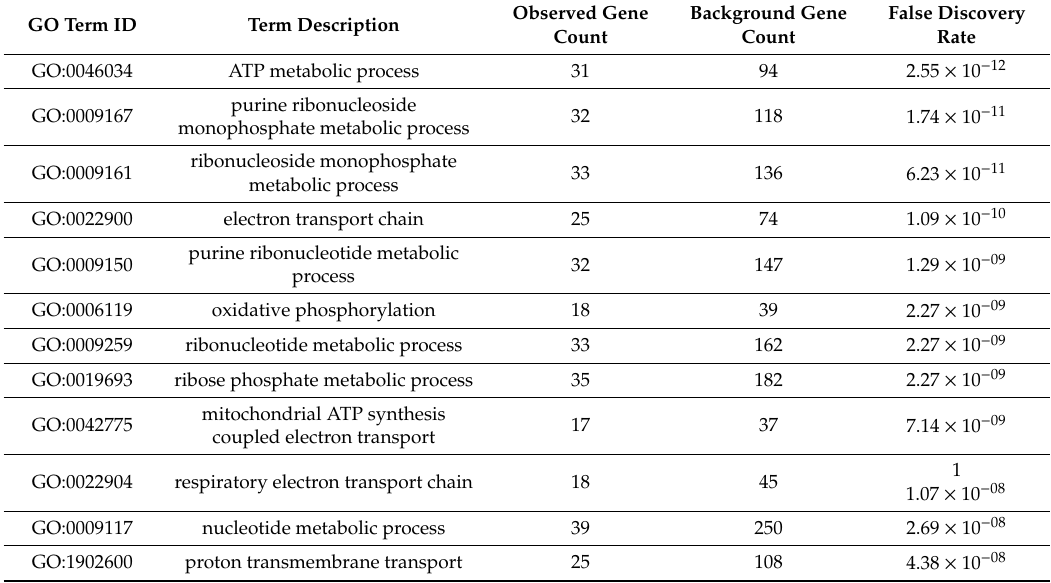
Figure 6. Codon usage trends in groups of transcripts corresponding to proteins regulated in sua5 cells. ( A ) Insoluble proteins up-regulated (fold change > 1.2, p < 0.05) in sua5 cells have corresponding transcripts that over-use AUU, ACG, AAC and AGA codons. ( B ) Soluble proteins down-regulated (fold change < 0.7, p < 0.05) in sua5 cells have corresponding transcripts that over-use AAC and AAG codons. The color-coded table describes the increased (yellow) or decreased (purple) codon frequency changes in a group of regulated proteins relative to genome averages (Codon -Group - Codon -Genome ) for each of 64 codons, with white boxes describing changes less than 0.05. The t 6 A dependent codons are the ones in the red-box. Table 4. STRING functional enrichment analysis of genes that only use AGA or AGG codons for arginine. The observed gene count is the number of genes from the target list found in each functional category, with the background gene count describing the total number of genes found in the